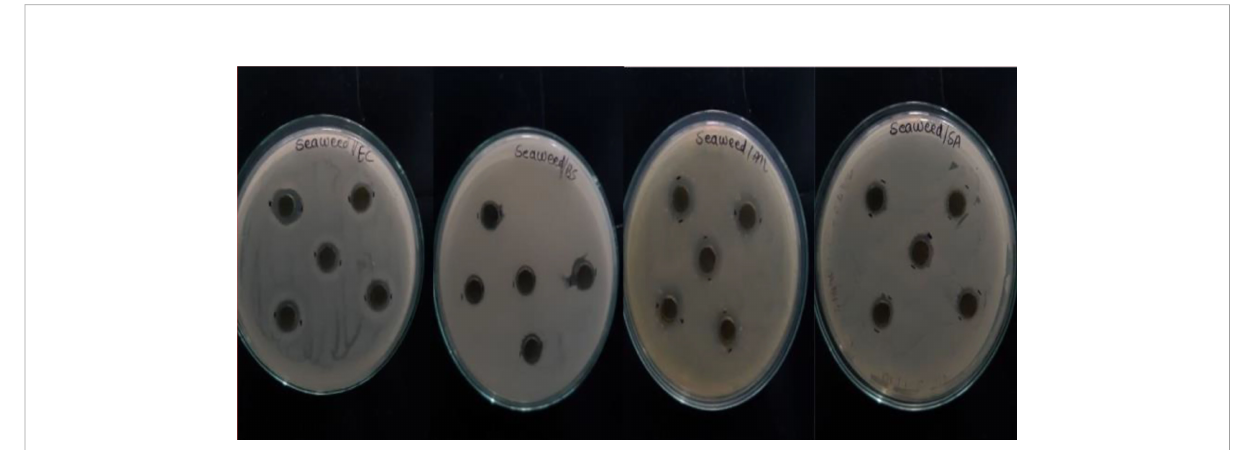
FIGURE 6 Inhibition zone antibacterial activity of Sargassum extract.